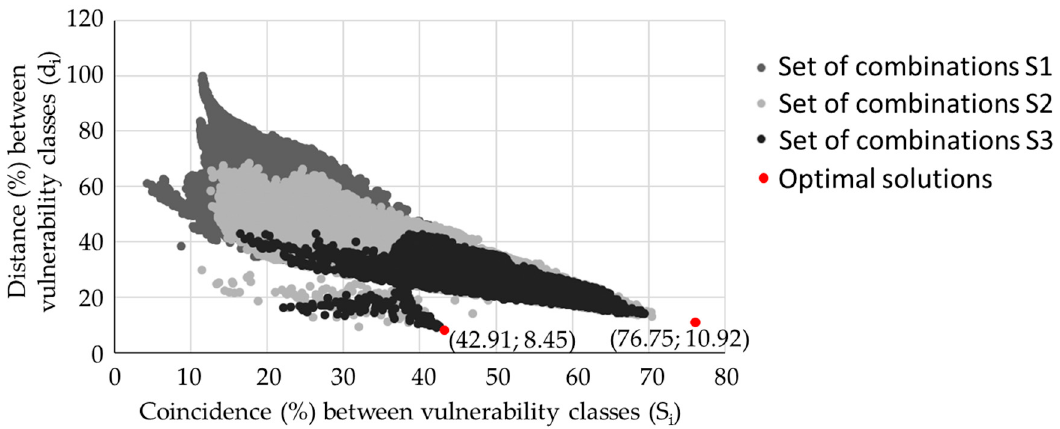
Figure 5. Results of objective functions for all DRASTIC combinations.